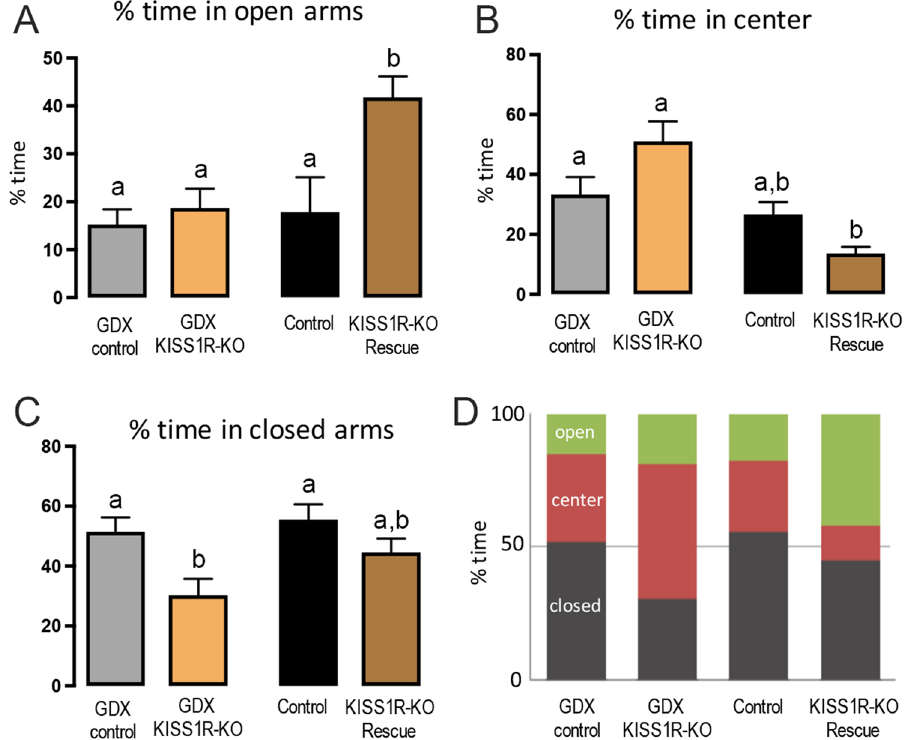
Figure 1. Elevated plus maze performance of gonadectomized (GDX) and intact KISS1R-KO mice. Different letters above histograms indicate statistically significant differences between GDX control (N = 9), GDX KISS1R-KO (N = 7), intact control (N = 8) and intact KISS1R-KO rescue (N = 9) mice. ( A ) Histograms showing the percentage of time mice spent in the open arms of the maze. b = P < 0.01, Tukey’s post-hoc multiple comparisons against all other groups. ( B ) Histograms showing the percentage of time mice spent in the center of the maze. a. vs b. = P < 0.05, Tukey’s post-hoc multiple comparisons against GDX groups. ( C ) Histograms showing the percentage of time mice spent in the closed arms. b = P < 0.05, Tukey’s post-hoc multiple comparisons against KISS1R-KO groups. ( D ) Summary providing a comparison of percentage of time spent in all three compartments for each